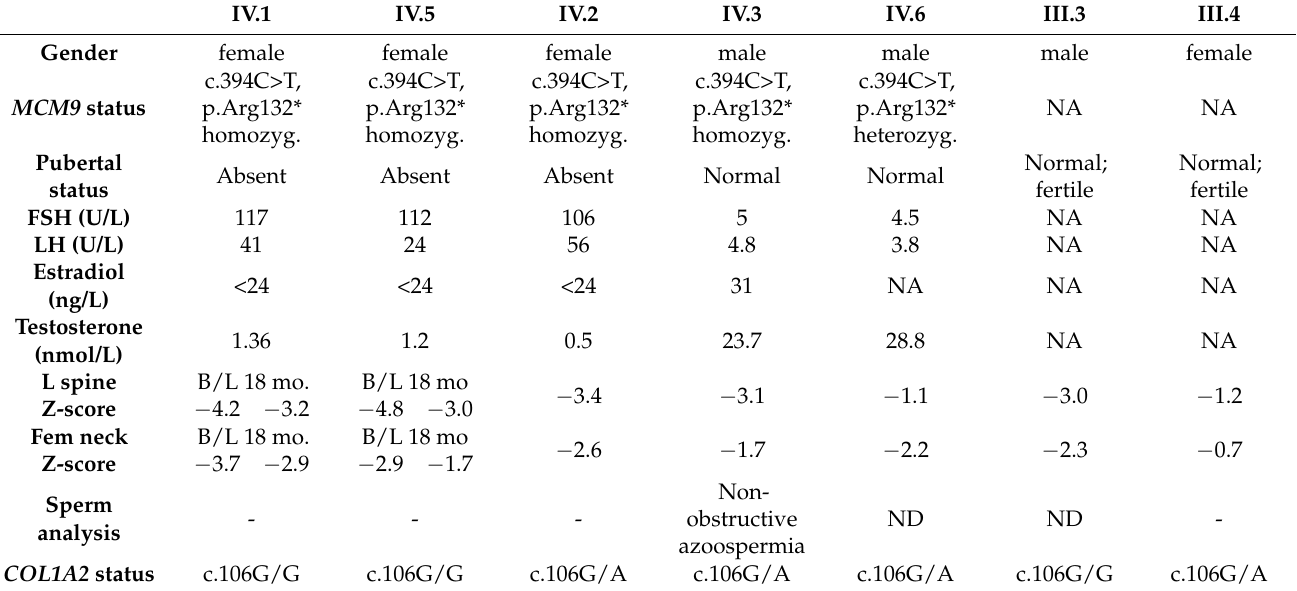
Table 1. Clinical, hormonal, genetic, and bone characteristics in subjects with MCM9 pathogenic